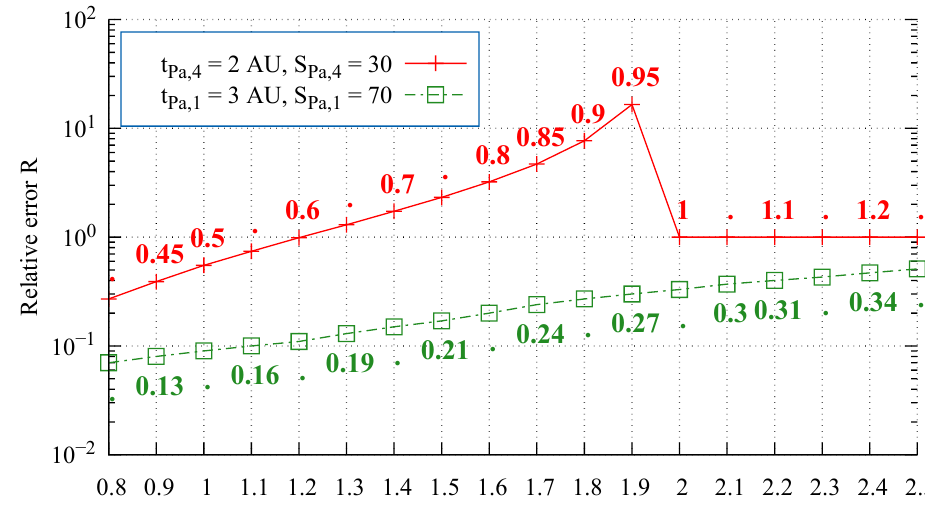
Figure 4. Relative error of the average value of overflow traffic, System 1, Resource 2 ( α values specified directly in the figure).